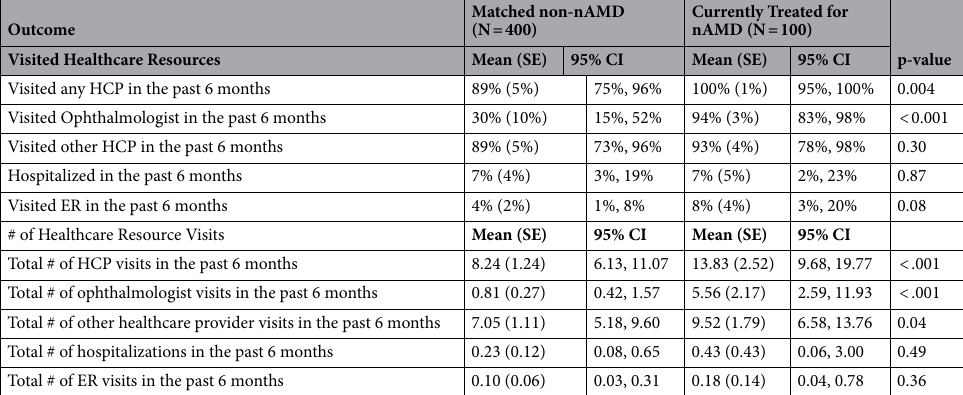
Currently Treated for nAMD (N =